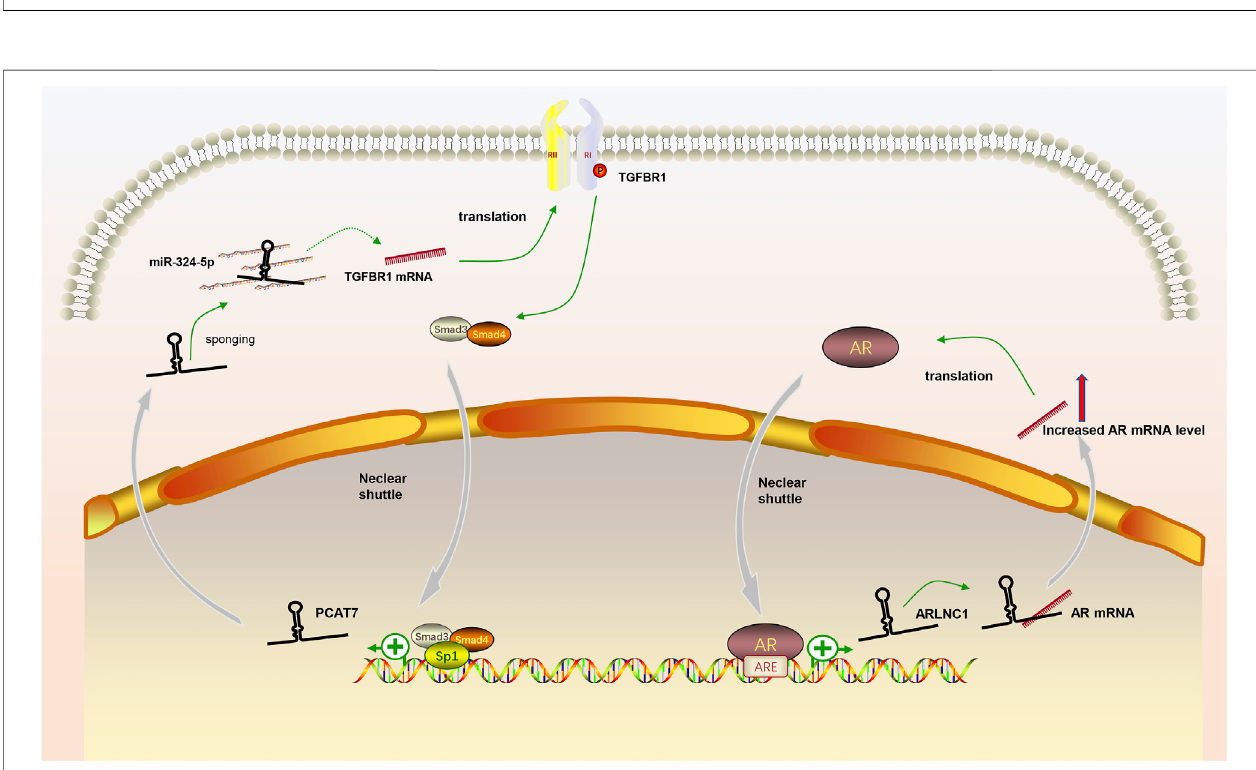
FIGURE 2 | The positive feedback loop between lncRNAs and key signaling effectors. (1) AR induced the expression of lncRNA ARLNC1 and ARLNC1 increased the stability of AR mRNA to promote AR signaling pathway; (2) LncRNA PCAT7 increased the level of TGFBR1 and activated TGF- β /Smad signaling pathway promoted the expression of PCAT7 via the formation of Smad3/Smad4/SP1 complex.